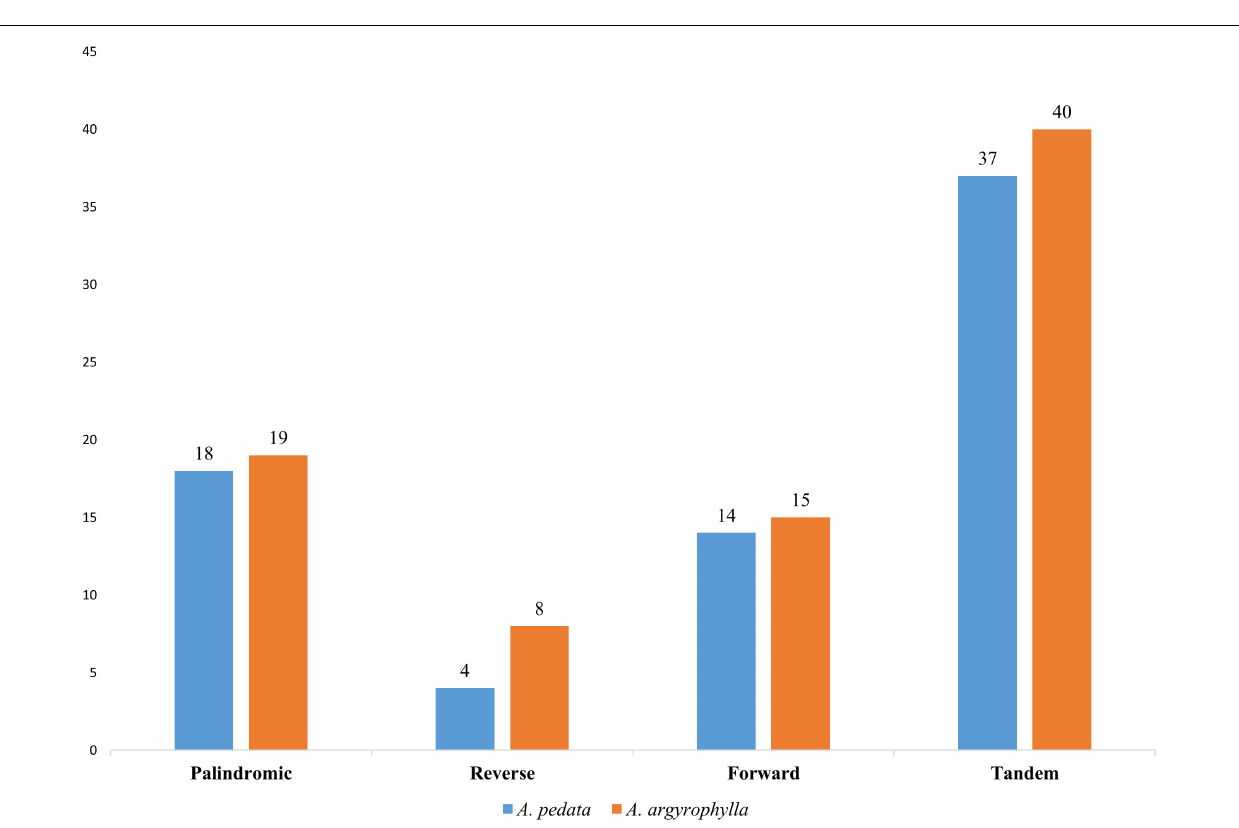
FIGURE 2 | Number of long repeat sequence types in Alchemilla pedata and Alchemilla argyrophylla in the distribution of palindromic, reverse, forward, and tandem repeats.